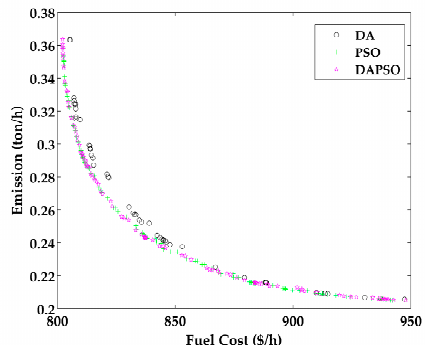
Figure 2. Two-dimensional Pareto fronts when considering fuel cost and emissions as part of the objective function for the IEEE 30-bus system.